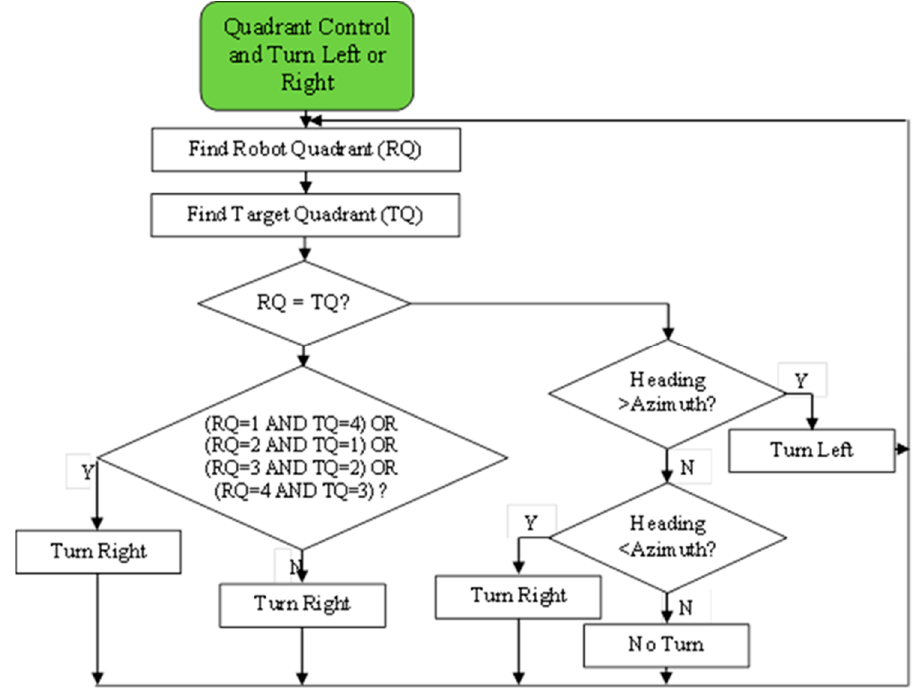
Figure 4. The flowchart of the quadrant control mechanism.